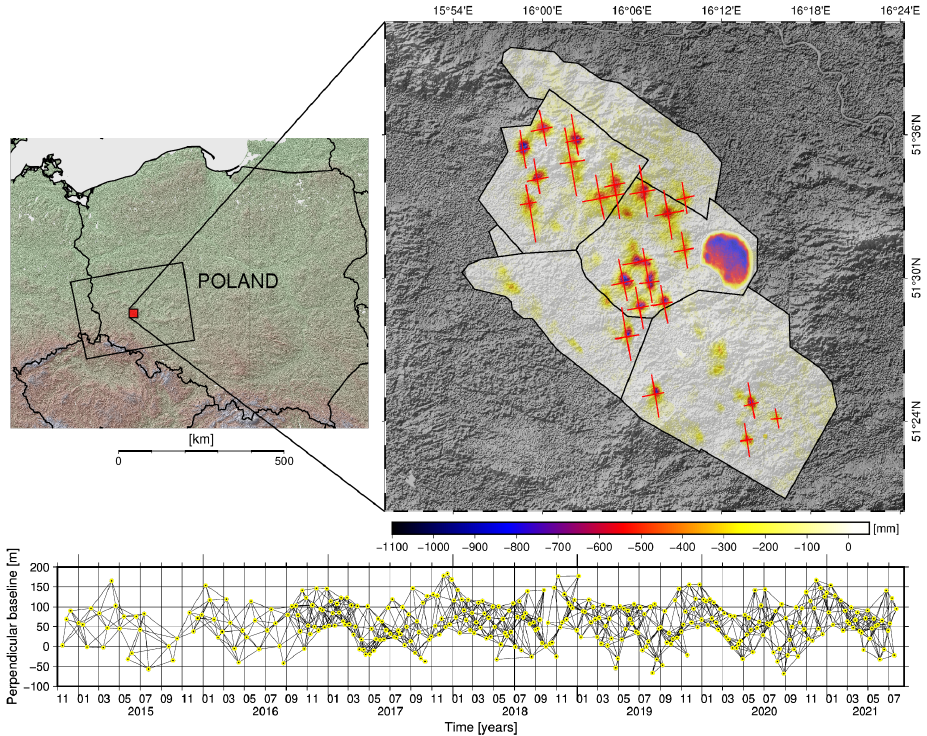
Figure 1. Location of the research area and the displacement results calculated with the SBAS method Red lines represent profiles located within the borders of the largest identified subsidence troughs. Each of the profiles is represented by a set of points used in forecasts. The lower part comprises a graph of baselines for the SBAS calculations of the radar